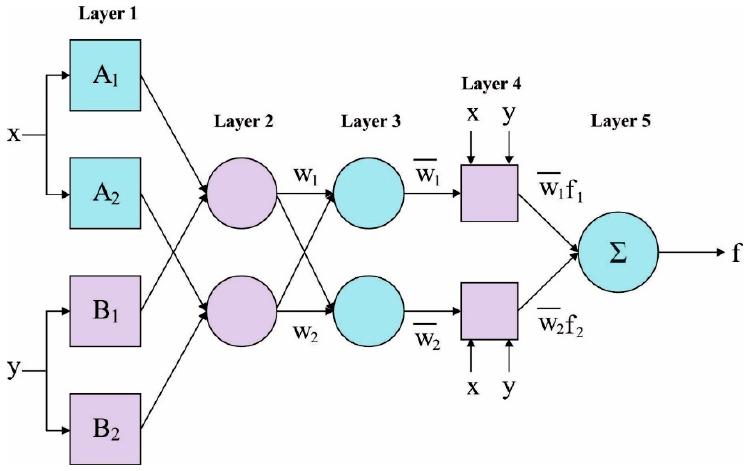
Figure 2. Structure of ANFIS [27].